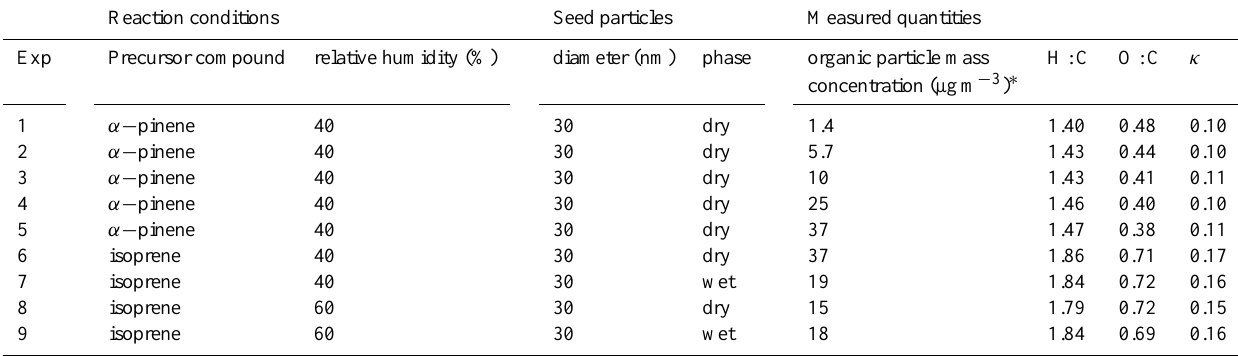
Table 2. Summary of experimental conditions for the HEC experiments. Reaction